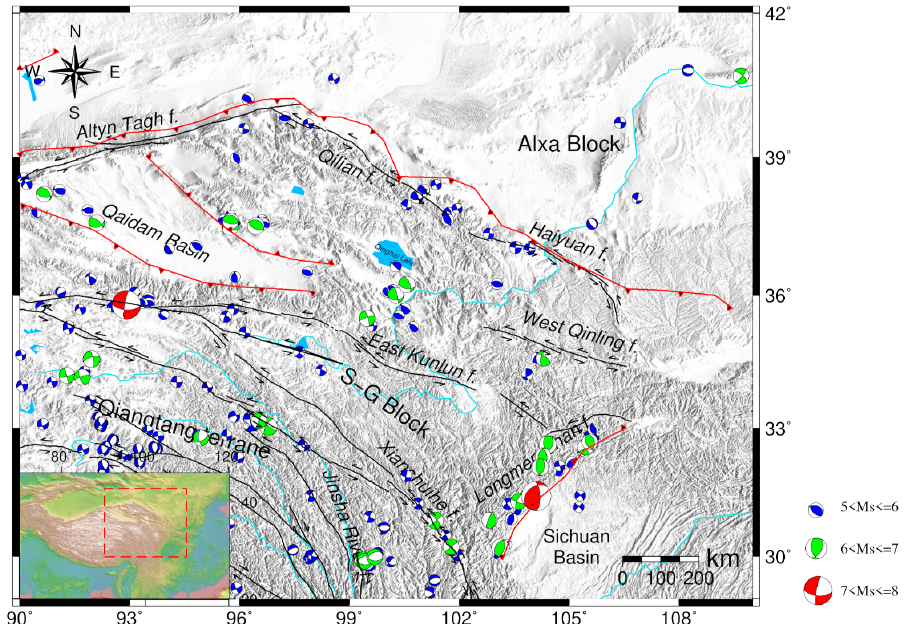
Figure 1. Tectonic background in NET. The earthquake focal mechanisms are from the Global CMT (Centroid Moment Tensor) catalogue from 1 January 1976 to 1 January 2017. Main faults are annotated as black curves, and subduction zones are annotated as red